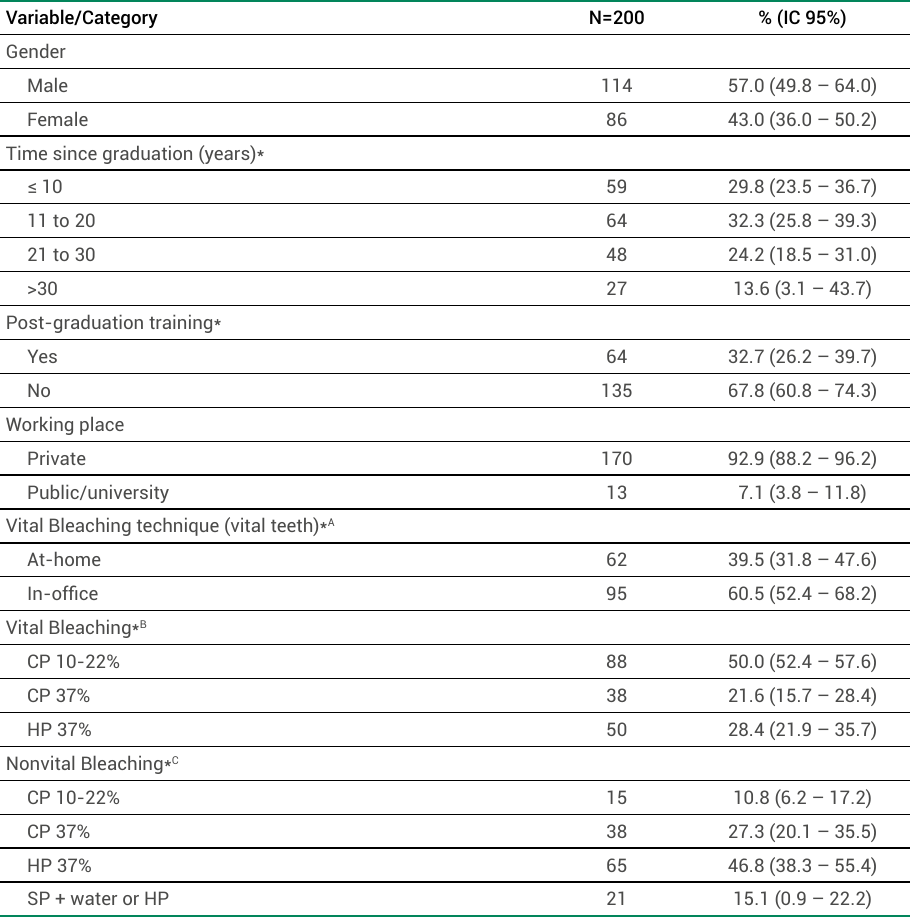
Table 1. Descriptive analyses of the studied variables among Guatemalan dentists (n=200). Guatemala,